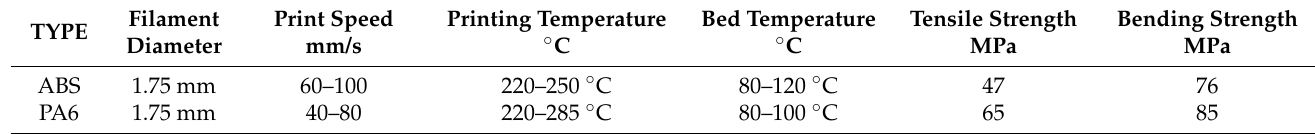
Table 1. Specifications of materials for experiments (Data credit: